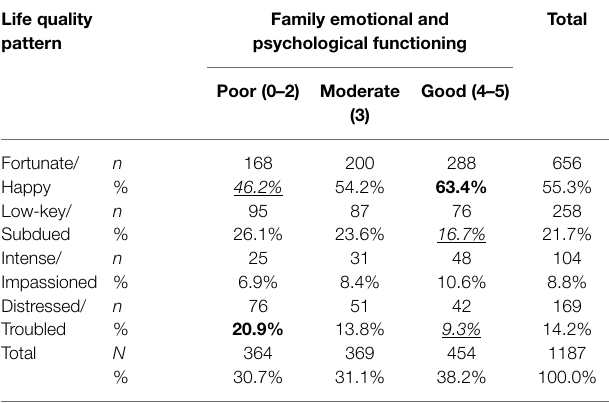
TABLE 9 | Trainees’ current life quality by family of origin emotional function. 1,2